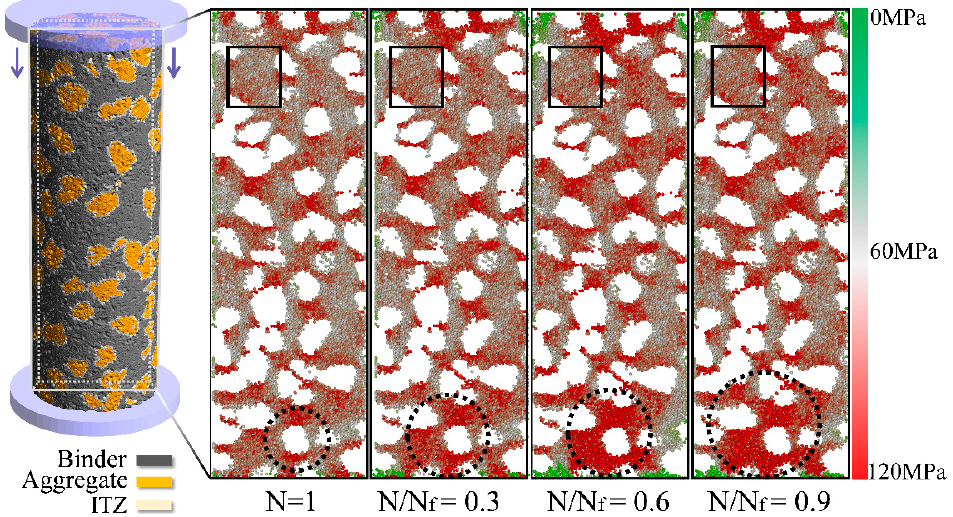
Figure 11. Visualization of stresses on primary binder particles at the upper load level 𝑆 u and different fatigue stages; stresses are analyzed in the loading direction.